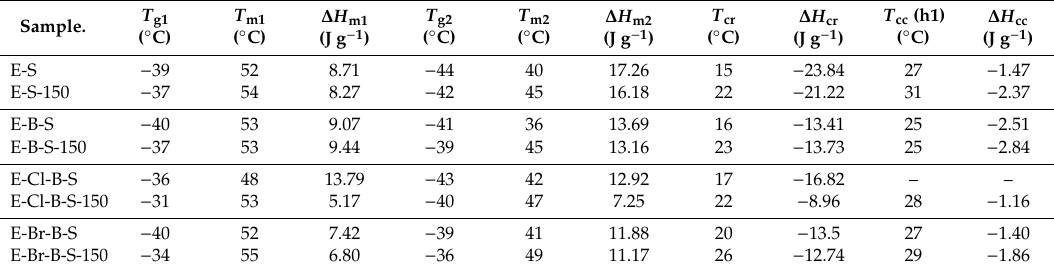
Table 4. Summary of thermogravimetric analyses (TGA) results for the EPDM composites. Sample